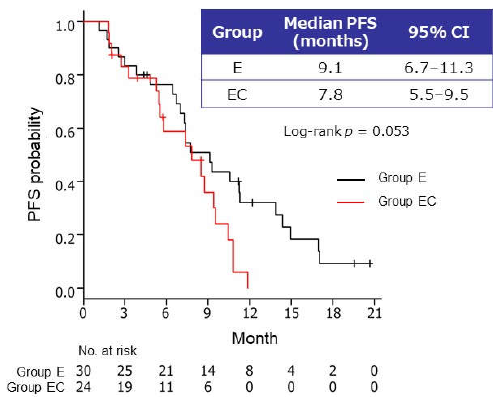
Figure 3. Kaplan–Meier curves of progression-free survival (PFS) in patients who received bevacizumab–paclitaxel rein- duction therapy after maintenance therapy with endocrine therapy alone (group E) or endocrine therapy plus capecitabine (group EC). CI, confidence interval; E, endocrine therapy alone; EC, endocrine therapy plus capecitabine.